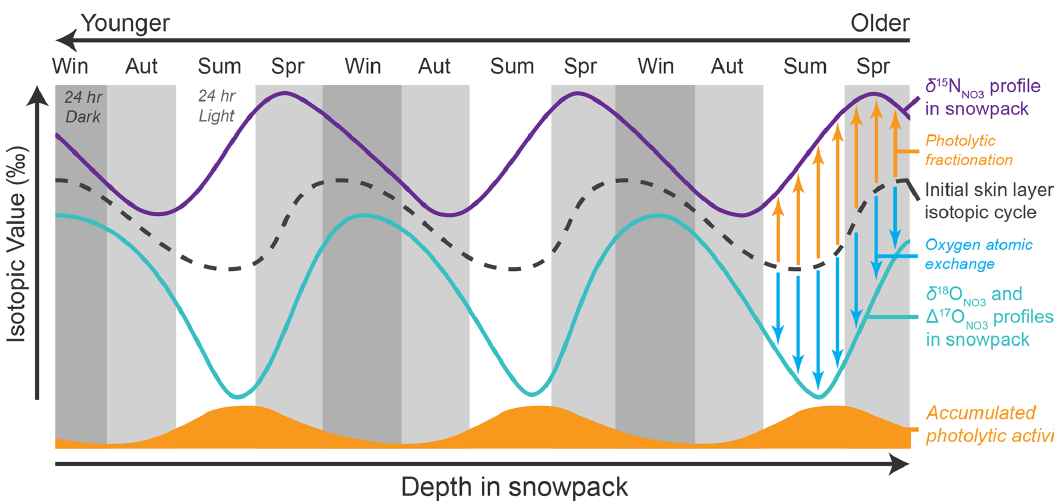
− , δ 18 O NO , and (cid:49) 17 O NO have . Even if δ 15 N NO Figure 6. The proposed mechanism for observed isotopic cycle offsets in snow pit NO 3 3 3 3 synchronous seasonal isotopic cycles when deposited in the skin layer (black dashed line), post-depositional photolysis will skew δ 15 N NO 3 values (purple solid line) differently than δ 18 O NO and (cid:49) 17 O NO values (teal solid line). Photolysis increases isotopic values for nitrogen 3 3 due to photolytic fractionation (orange arrows) but decreases values for oxygen due to oxygen atomic exchange (blue arrows). Because the typical amount of photolytic activity experienced by NO − deposited on the snow surface (orange solid curve) also changes seasonally in a 3 cycle not aligned with the skin layer isotopic value cycles, photolysis will enhance or subdue the existing skin layer isotopic cycle differently for δ 15 N NO than for δ 18 O NO and (cid:49) 17 O NO . This produces the observed cyclical offsets between nitrogen and oxygen isotopes (Fig. 4), 3 3 3 even if the magnitude of isotopic value changes due to photolysis (i.e., the size of the arrows) is the same for all isotopic species at a given point in the